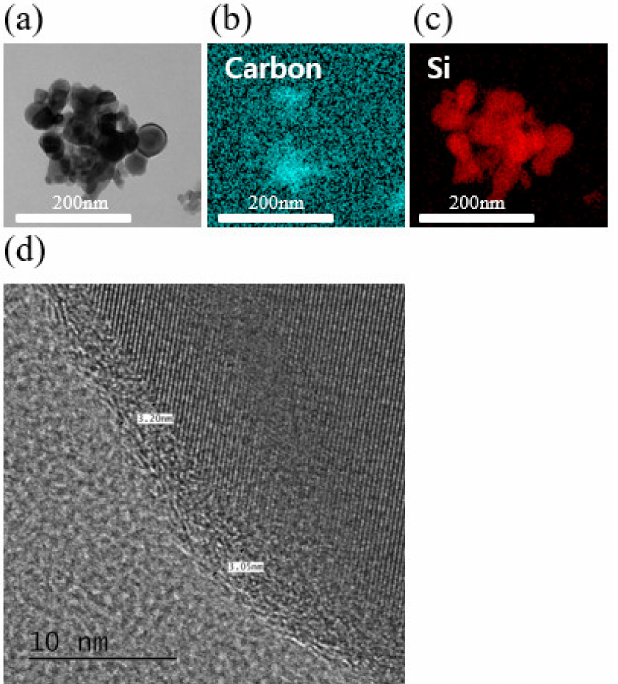
Figure 2. TEM micrographs; ( a ) image of SCB, ( b , c ) corresponding elemental mapping of carbon and silicon, ( d ) HRTEM